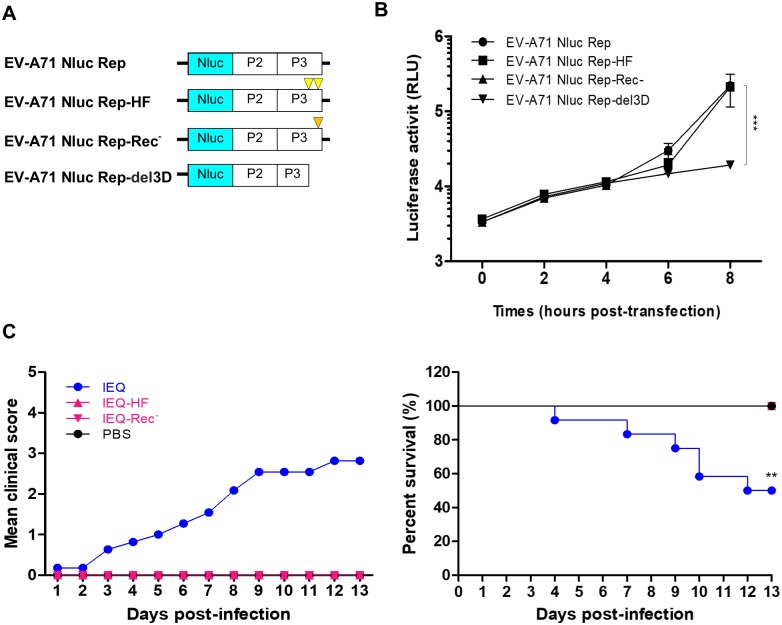
High fidelity and impairing recombination attenuate in vivo virulence of IEQ.The RdRp of IEQ was modified to harbor the high fidelity G64R and L123F mutations (HF) or the recombination-deficient Y276H mutation (Rec-) and virulence was analyzed in mice. (A) EV-A71 subgenomic replicon (EV-A71 Nluc Rep), EV-A71 Nluc Rep-HF (HF mutations are indicated by yellow triangles), EV-A71 Nluc-Rep-Rec- (Rec- mutation is denoted by orange triangle) and truncated replicon (EV-A71 Nluc Rep-del3D) were transfected separately into RD cells. (B) Luciferase activities were determined up to 8 hours post-transfection. Significant differences between replicon variants and WT are labelled as *** (P < 0. 001). (C) Virulence of IEQ-HF, IEQ-Rec- and IEQ following i.p. infection of mice was measured by clinical scores and percentage of survival. IEQ-HF and IEQ-Rec- curves are identical to that of the mock-infected PBS group. Significant difference between viral variants and IEQ is labelled as ** (P < 0.01).